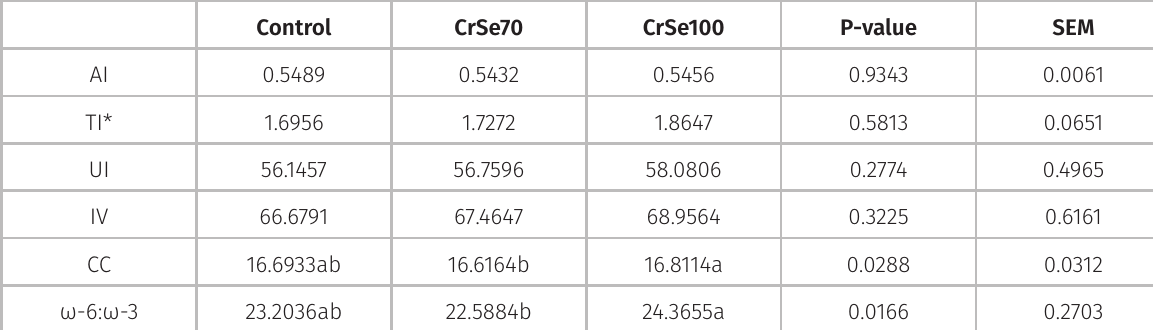
Table VI. Atherogenic, thrombogenic and unsaturation indices, iodine value, carbon length chain, and ω -6: ω -3 ratio, of swine supplemented with organic chromium and